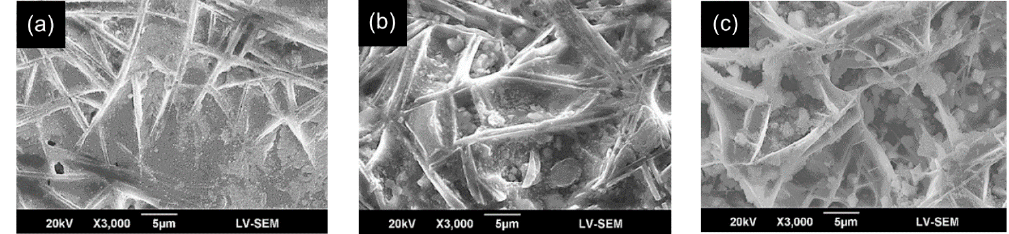
Figure 5. SEM metallographs of CL surface in FA/ZrO 2 laser-clad specimens: ( a ) 400 W, 200 mm/min; ( b ) 800 W, 400 mm/min; and ( c ) 1200 W, 600 mm/min.